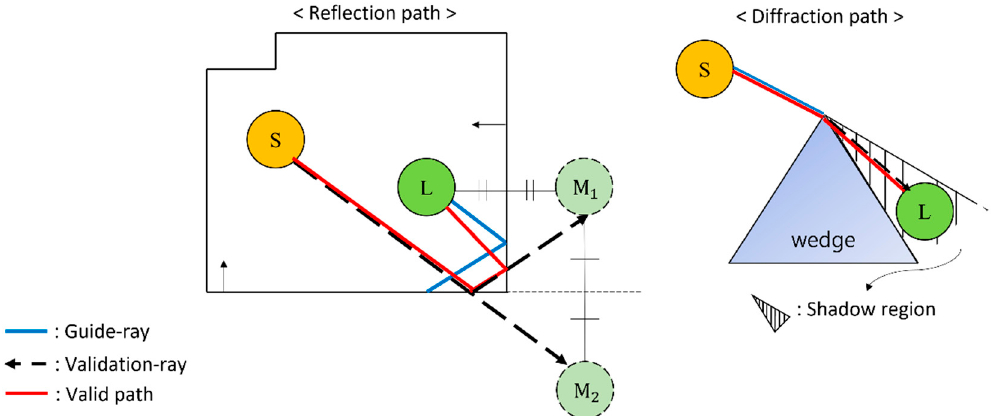
Figure 4. Two examples showing validation test for 2-order specular reflection path ( left ) and 1-order diffraction path ( right ), respectively. Validation test for reflection path: The listener (L) is reflected recursively over the sequence of reflecting hit-triangles. Through this, listener mirror images (M 1 , M 2 ) are created. Then, occlusion tests are performed while a validation ray shooting from the sound source (S) to the last listener image (M 2 ) is specularly reflected back to the L. If the tests are successful, valid reflection paths are created. The validation test for the diffraction path: Check if L is in the shadow region based on the wedge containing the hit-triangle. If L is within the region, the three edge points closest to the LS straight line are calculated for the three edges included in the hit-triangle. Then, occlusion tests are performed through the validation rays shooting from the edge points to L. If the tests are successful, valid diffraction paths are